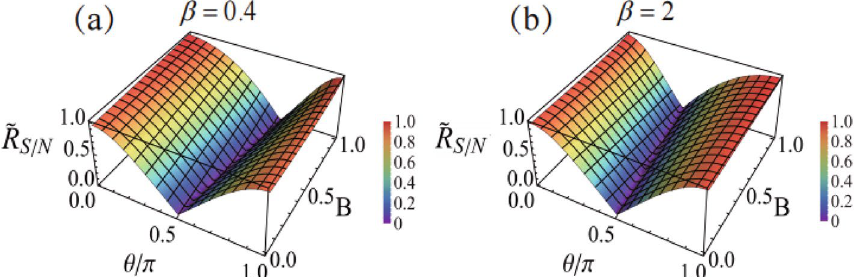
0.4 and 2 in ( a ) and ( b ). The =